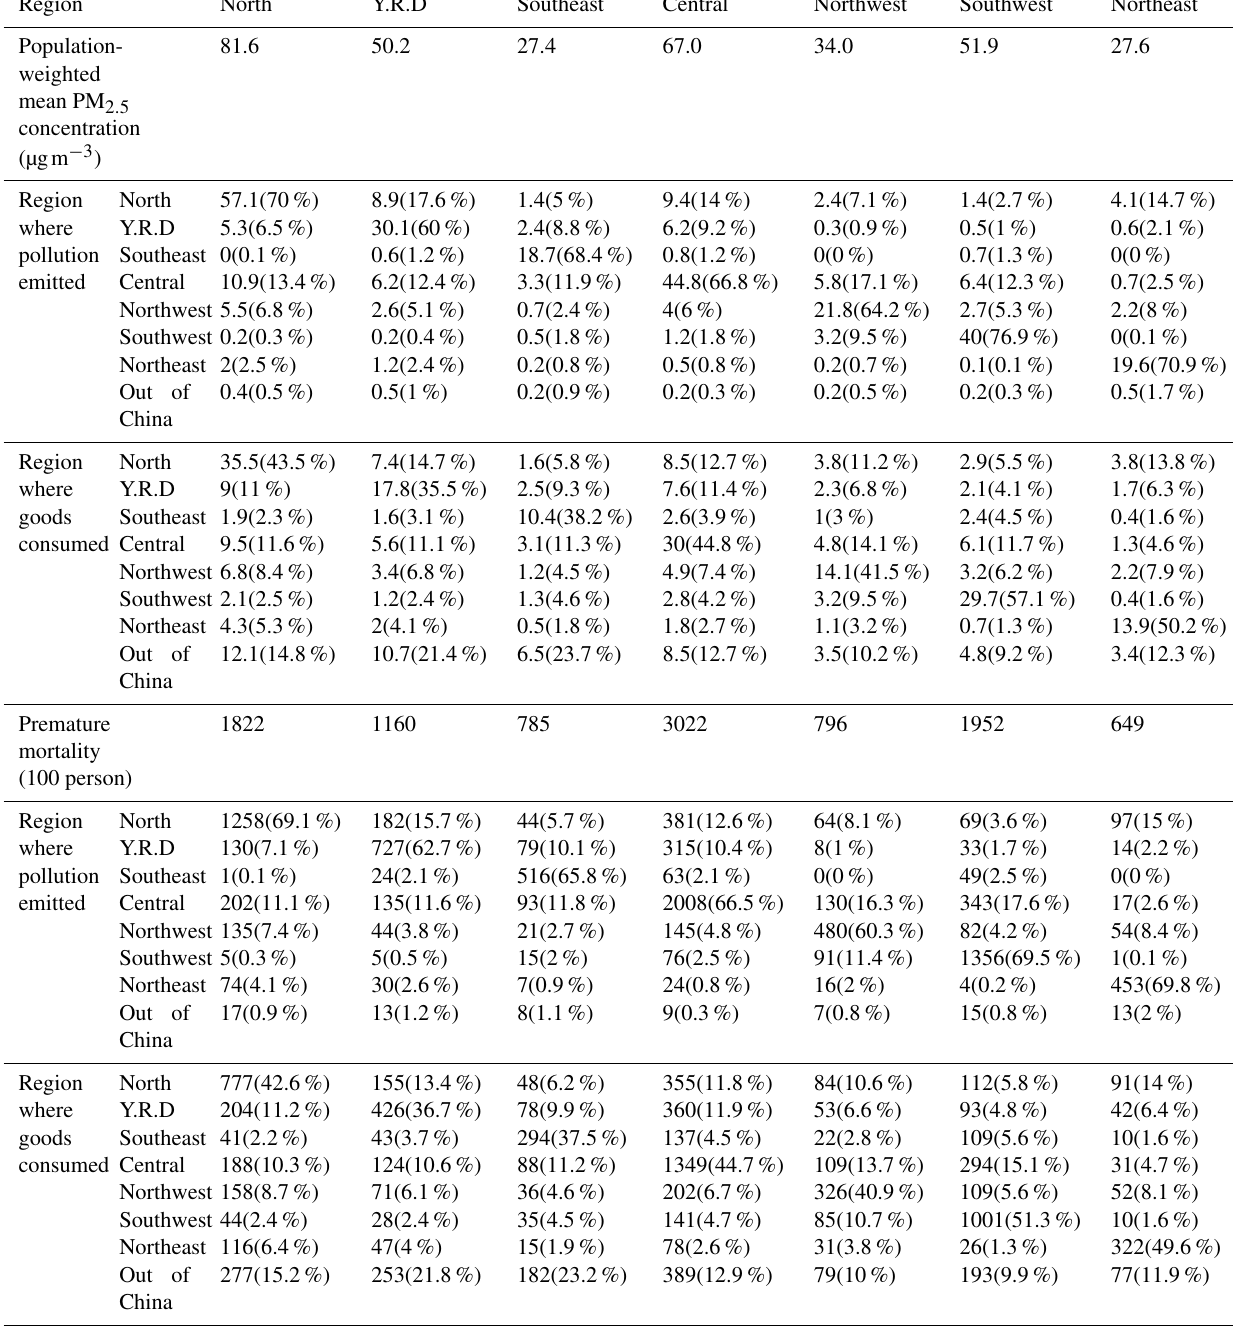
Table 2. Regional population-weighted mean PM 2 . 5 concentration in 2010 and related premature deaths from production and consumption perspectives. Each number in the cell shows the population-weighted mean PM 2 . 5 concentration or premature deaths in the region indicated by the column due to pollution emitted or goods consumed in the region indicated by the row. Numbers in the parentheses represent the fraction of population-weighted mean PM 2 . 5 concentration or premature